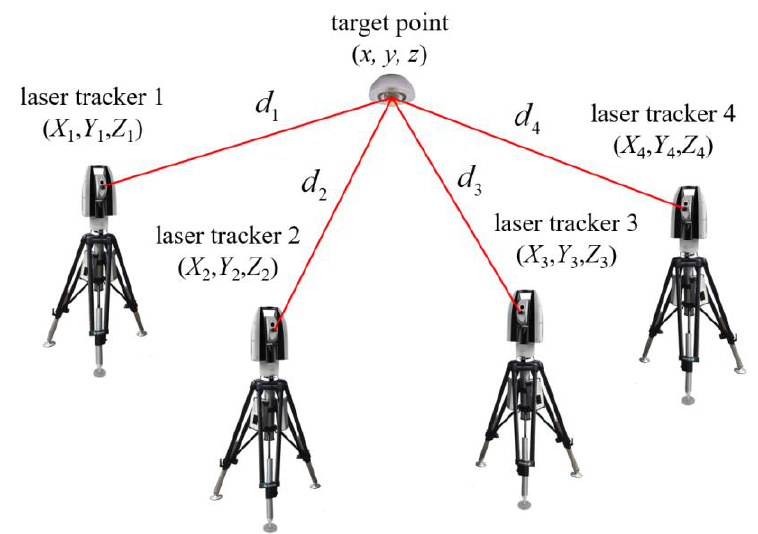
Figure 1. Measurement principle of laser multilateration. For the four laser tracker stations ( X j , Y j , Z j ) , j = 1, . . . , 4, control them to track the same target ball ( x , y , z ) , then the distance d i from each station to the reflective target ball can be obtained. Tour distance equations can be established as follows.